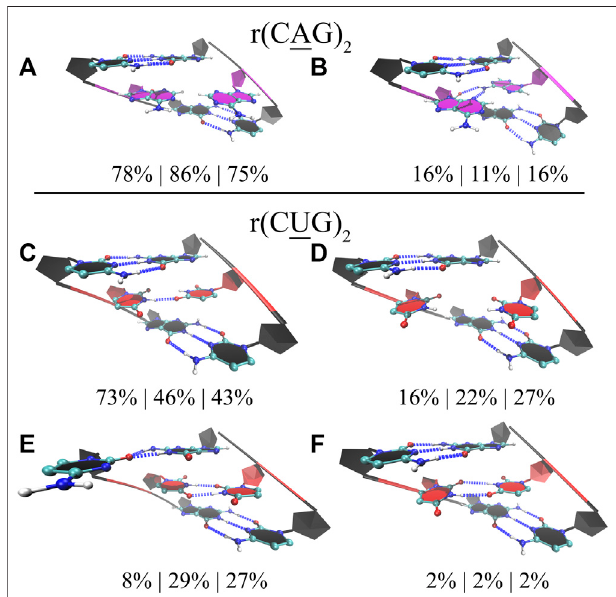
FIGURE 6 | Cluster analyses performed on model RNA systems mimickingCAGandCUGrepeats.Panelsatofdisplaystablestatesobserved in the MD trajectories such as zero (A) and one hydrogen bond (B) states observed in 1×1 AA internal loops, and one (C) , zero (D) , and two hydrogen bonds (E,F) states observed in 1×1 UU internal loops. Residues colored in red, blue, and magenta represent uridine, cytidine, and adenosine, respectively,whileclosingbasepairsaredisplayedinblackandinnewribbons form. Dashed blue lines represent the hydrogen bonds observed in the structures. Three model systems were utilized to study each RNA repeat, where2×CAG, 10×CAG,and 20×CAGwereused toinvestigate CAGrepeats and 2×CUG, 10×CUG, and 20×CUG were used to investigate CUG repeats. Three percentages displayed under each structure represent how often the structures were observed in the MD trajectories of the three model systems in the same order described